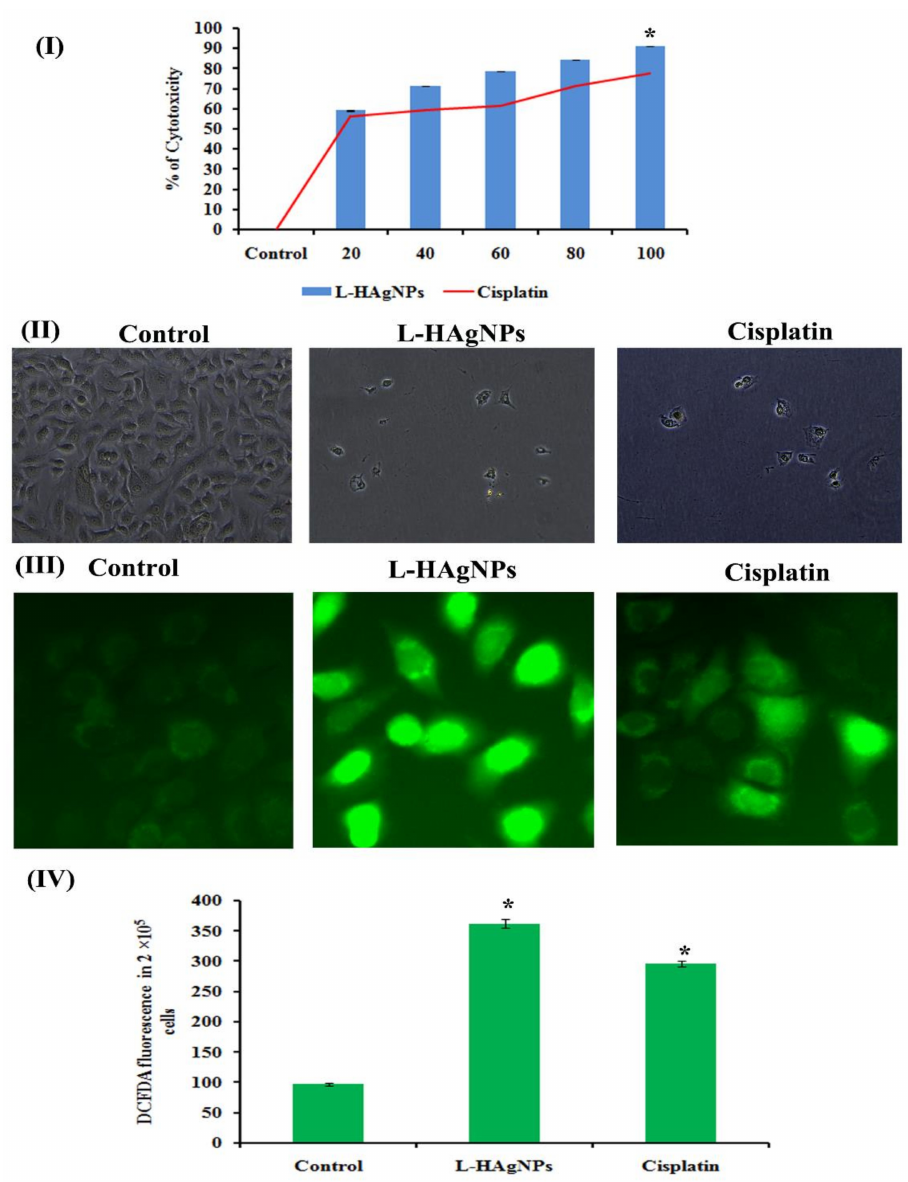
Figure 5. ( I ) Antiproliferative effect of L-HAgNPs against SiHa cells; ( II ) phase-contrast microscopic images to assess structural changes in cells treated with L-HAgNPs; ( III ) fluorescent images illustrat- ing intracellular ROS level; ( IV ) bar graph depicting quantitative measurement of green fluorescent intensity proportional to ROS level. * p < 0.05 denotes statistical significance between control vs. treated